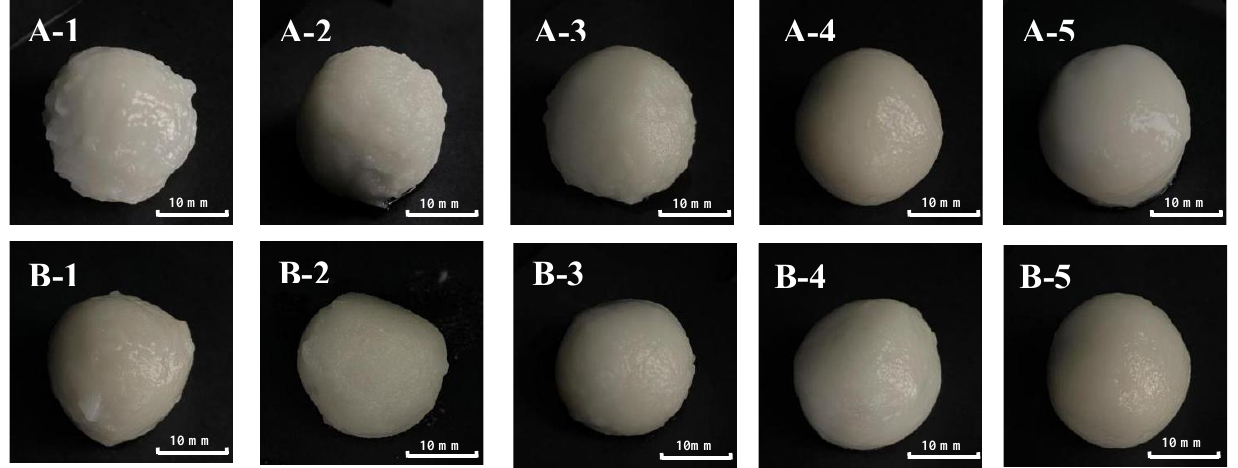
Figure 6. Appearance of waxy rice balls. A − 1 stands for IWR − D − 60, A − 2 stands for IWR − D − 120, A − 3 stands for IWR − D − 200, A − 4 stands for IWR − D − 320, A − 5 stands for IWR − W; B − 1 stands for JWR − D − 60, B − 2 stands for JWR − D − 120, B − 3 stands for JWR − D − 200, B − 4 stands for JWR-D − 320, B − 5 stands for JWR − W.